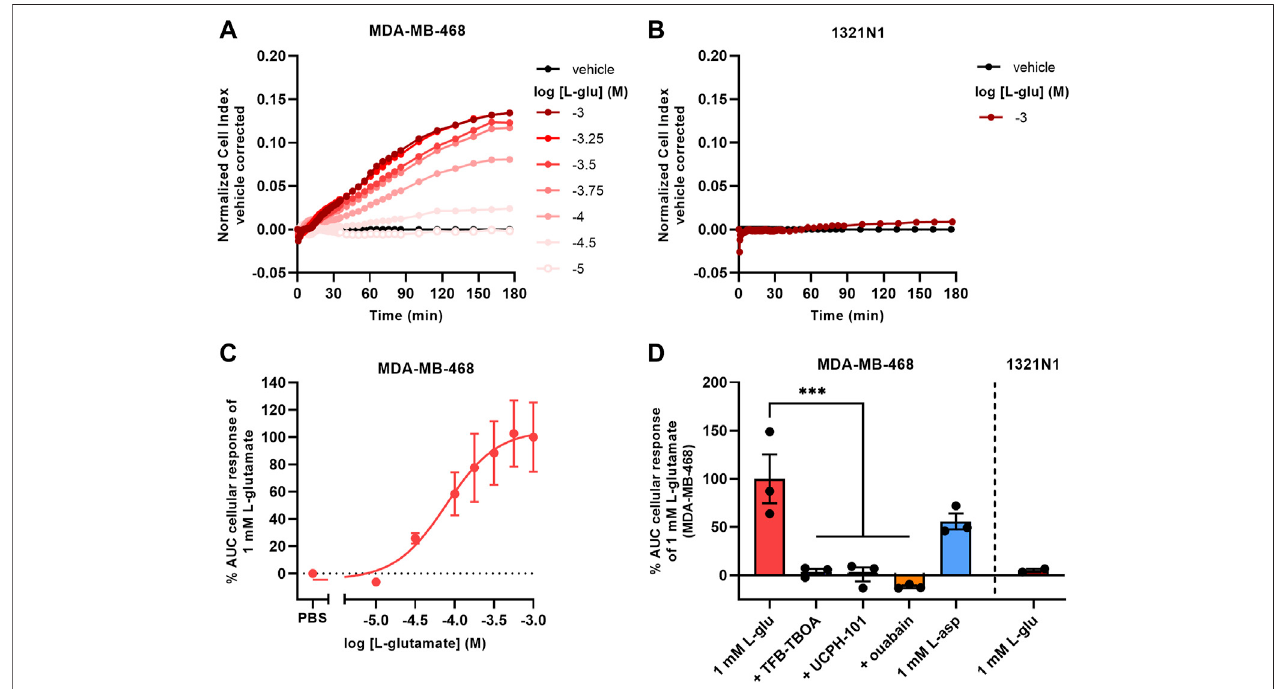
FIGURE 5 | L-glutamate induces cellular responses on MDA-MB-468 cells with endogenous EAAT1 expression. (A,B) Vehicle-corrected nCI traces of MDA-MB- 468 (A) and 1321N1 (B) cells stimulated with L-glutamate (L-glu), shown as the mean of a representative experiment performed in duplicate. (C) Combined concentration-response curve of L-glu on MDA-MB-468 cells. (D) Cellular response of L-glu or L-aspartate (L-asp) on MDA-MB-468 and 1321N1 cells. MDA-MB-468 cellswerepretreatedfor1 hwithvehicle(PBS/DMSO),10 µMTFB-TBOA,10 µMUCPH-101or1 µMouabainpriortostimulationwithvehicle(PBS),1 mML-gluor L-asp. Data are shown as the mean ± SEM of three (MDA-MB-468) or SD of two (1321N1) individual experiments each performed in duplicate. *** p < 0.001; one-way ANOVA with Dunnett ’ s post-hoc